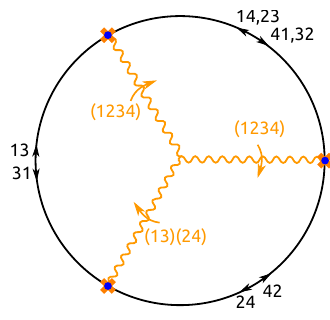
Figure 2 . The distinguished directions and sheet labels emerging from the punctures, at # = # (cid:13) 5 (cid:25) . These serve as seeds for the S -walls making up the spectral network. 12